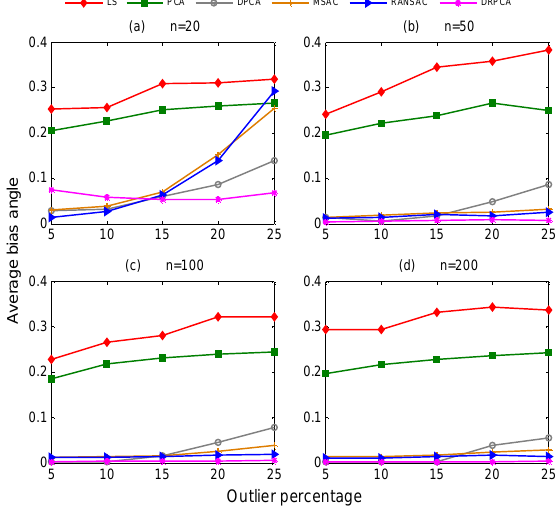
Figure 3. Average bias angle versus outlier percentage for different sample sizes and outlier percentages Variance